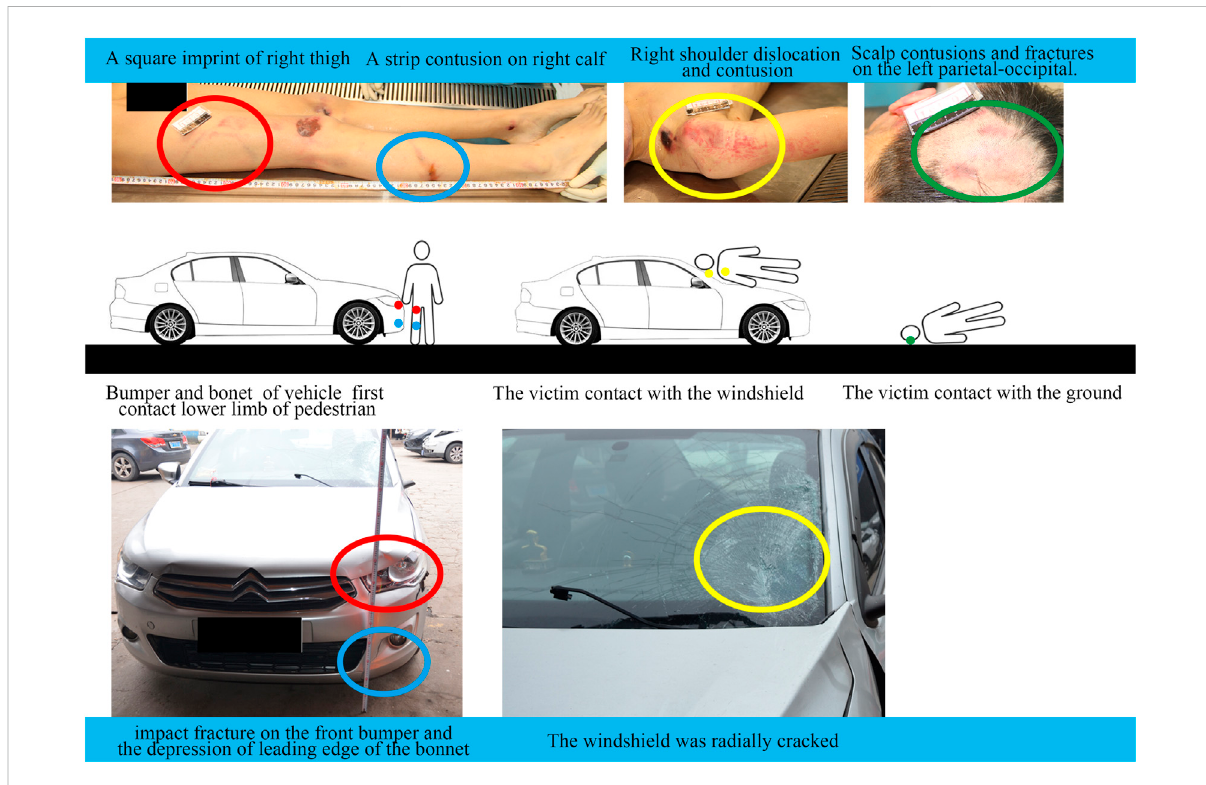
FIGURE 2 Pedestrianinjuriesandvehicledamagesindifferentstagesaftervehicle-pedestriantraf fi caccidents.Thecontactbetweenthepedestrian ’ sright thigh and the bumper cover is indicated in red, the contact between the pedestrian ’ s calf and the bumper is indicated in blue, the contact between the pedestrian ’ s shoulder joint and the windshield is indicated in yellow, and green indicates the fi rst contact between the pedestrian ’ s head and the